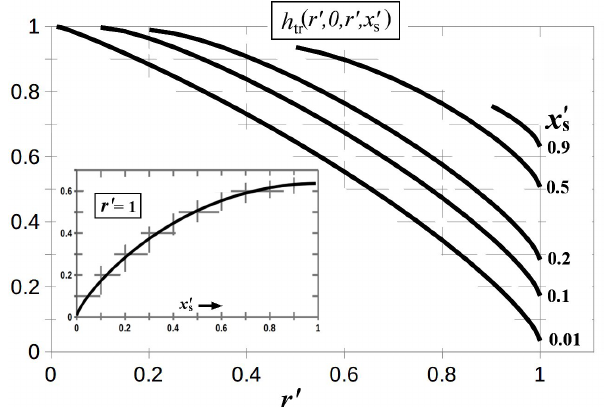
Figure A2. Basis function h tr for the thin ring. The function is eval- uated at z (cid:48) = 0 (i.e., the surface) and ρ (cid:48) at the position of the grow- ing face edge front (r (cid:48) ) . The five curves are for the x (cid:48) s values given on the right. Inset plot shows the dependence on x (cid:48) s when the edge front reaches the crystal perimeter at a (i.e., r (cid:48) = 1). Hatches show the